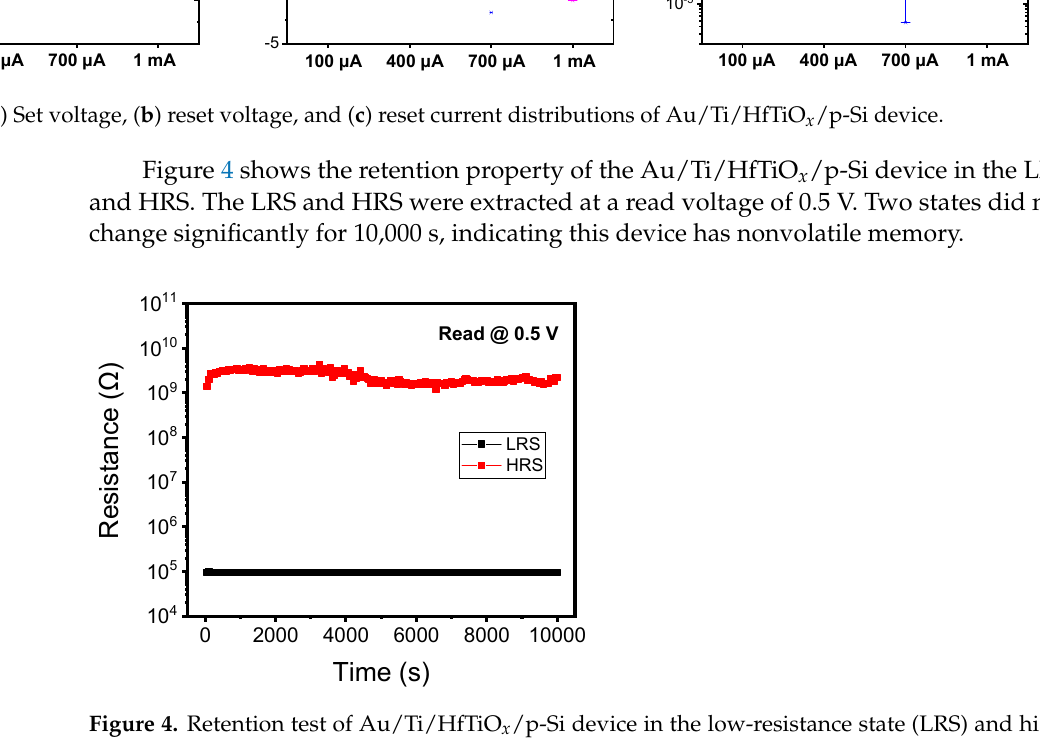
Figure 2. I-V characteristics of Au/Ti/HfTiO x /p-Si device with compliance current (CC) of ( a ) 100 µA and ( b ) 1 mA. ( c ) Resistive switching failure by full reset process. Figure 3a,b show the set voltage ( V SET ) and reset voltage ( V RESET ) distributions of Au/Ti/HfTiO x /p-Si device as a function of CC. V SET and V RESET are not particularly affected by CC. However, the reset current ( I RESET ) is slightly increased with increasing CC, indi- cating that in general a larger conducting filament is formed at a larger CC.